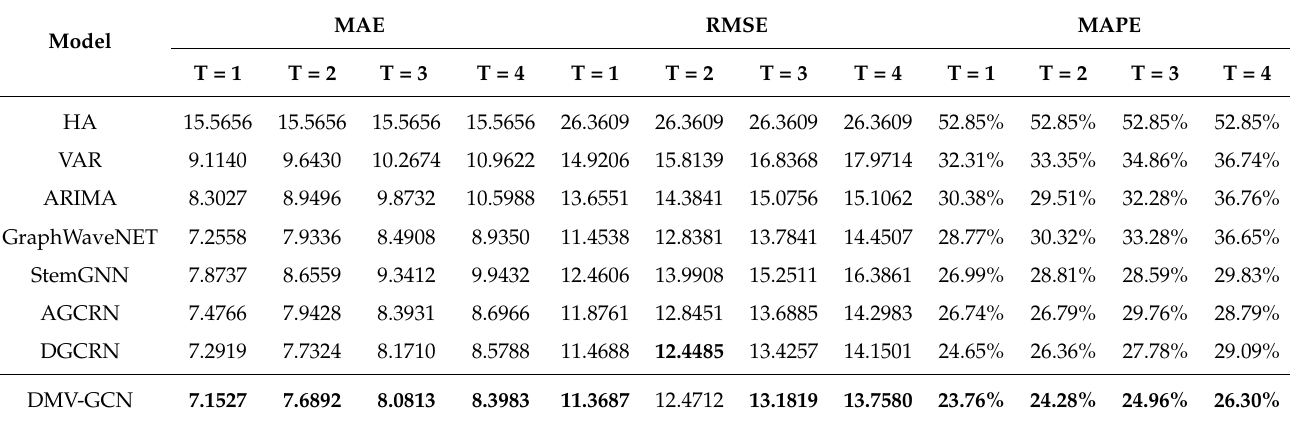
Table 1. Comparison of experimental results on the NYC-taxi-2016